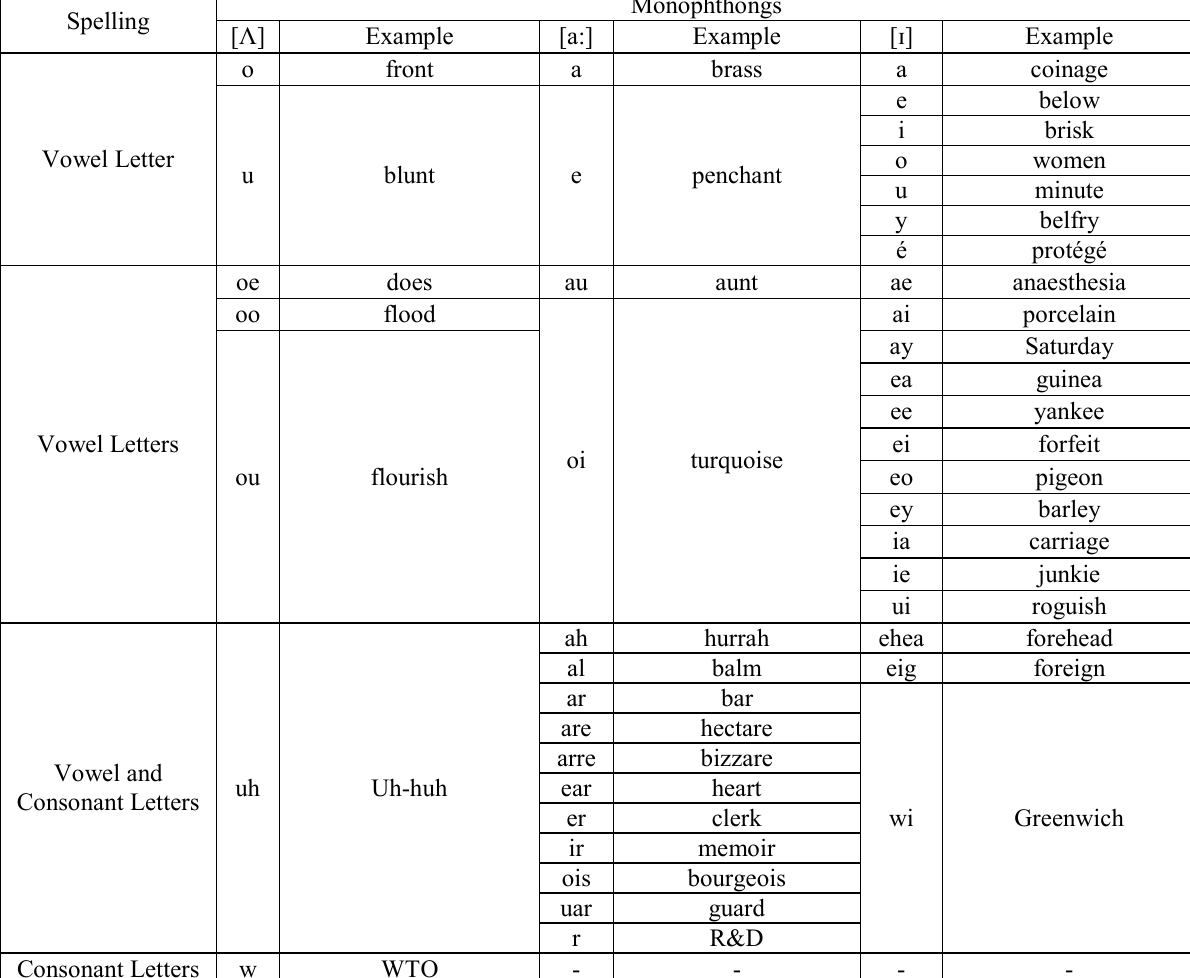
Table 1. Ways of Graphical Spelling of Monophthongs [Ʌ], [а :] and [ ɪ ]